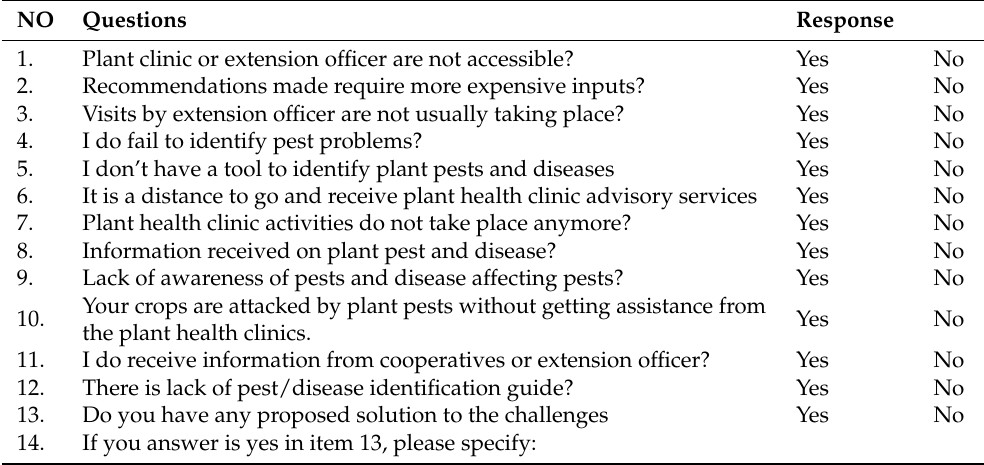
Table A4. Limitations of basic plant health clinic